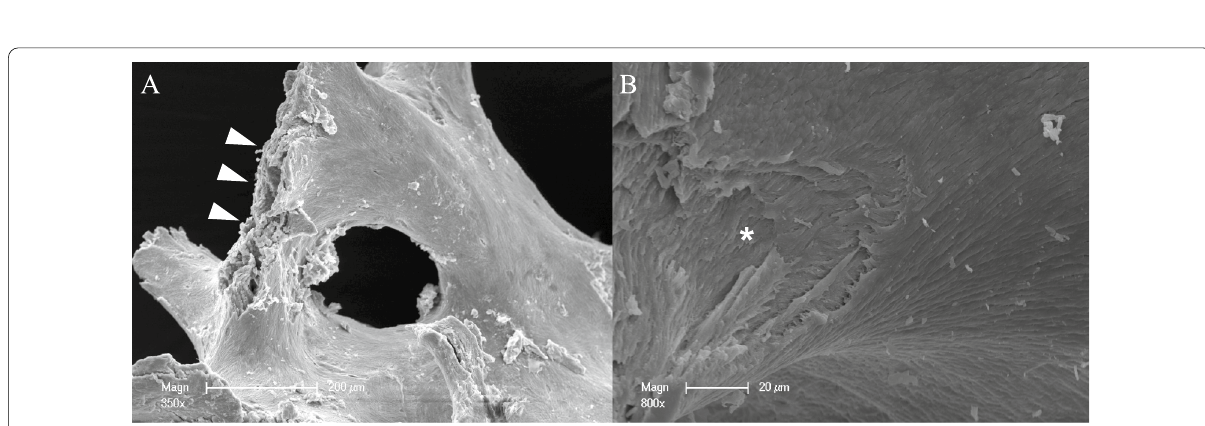
Fig. 2 Overview about the microscopic structure and architecture of allogeneic spongious granules by scanning electron microscopy (SEM) in A low (350-fold) and B high (800-fold) magnification. A Allogeneic bone compositions consist of about 5% water and 30% collagen that is visible by the fan-shaped spreading edges (white arrows) and B by a multi-layered structure created by collagen fibers (white asterisk). SEM is even highlighting the porous structure of allogeneic spongious granules that is suitable for fast and sufficient micro-vessel ingrowth and bone